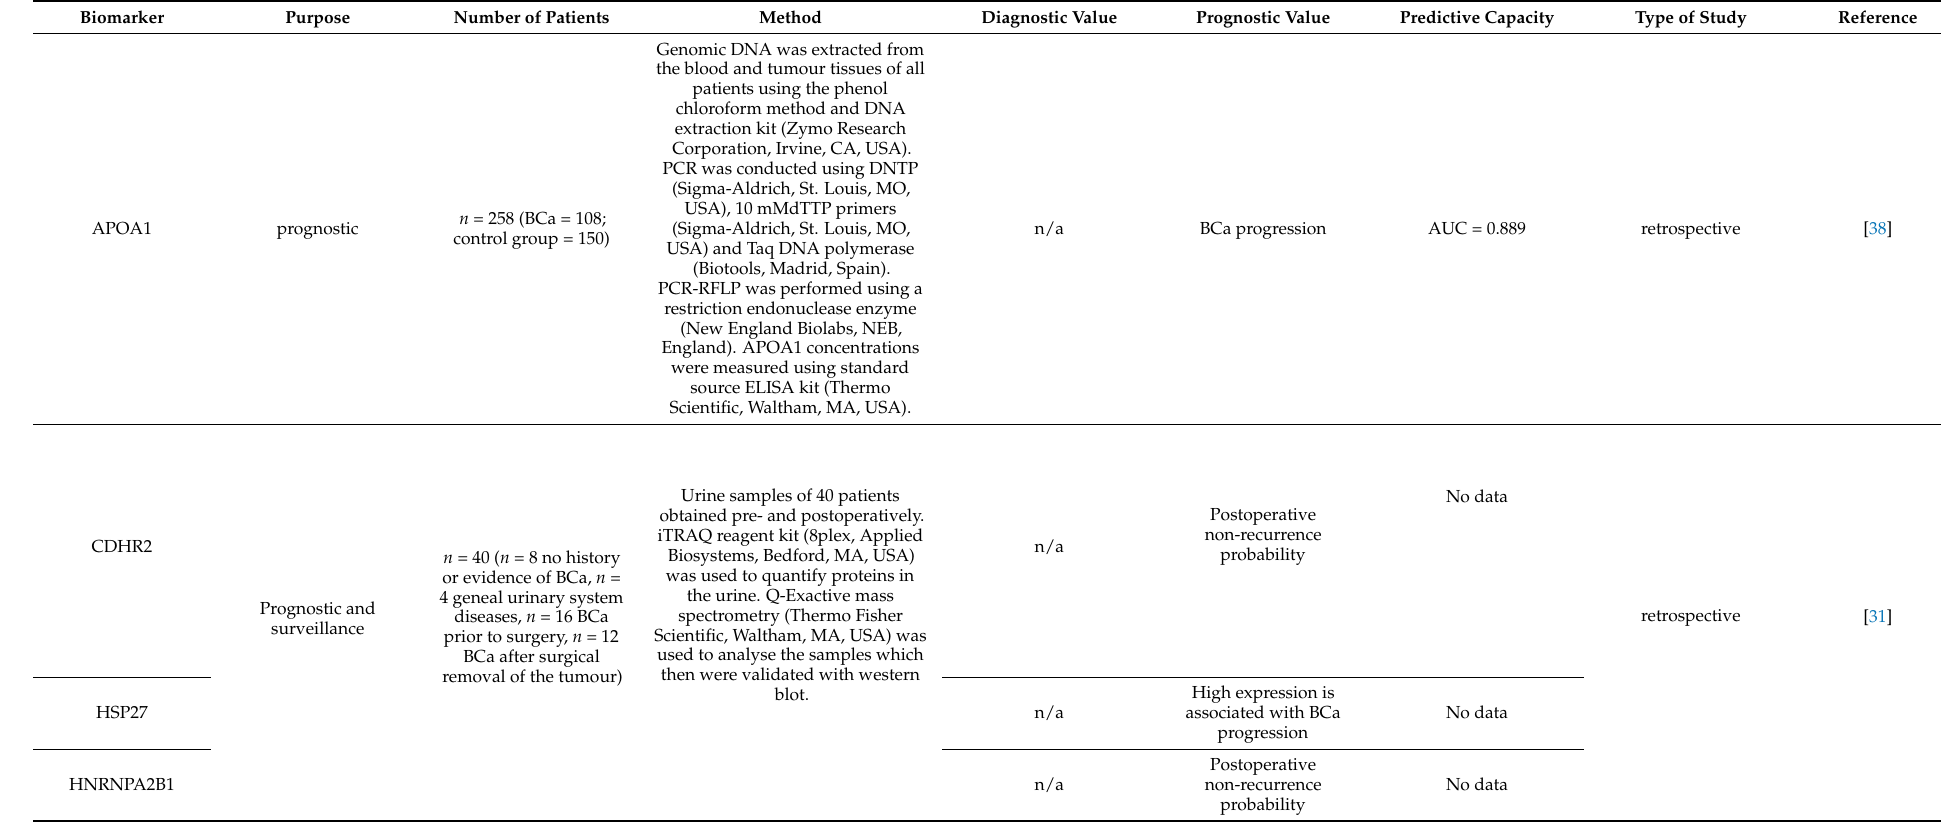
Table 3. Table presenting data for proteomics